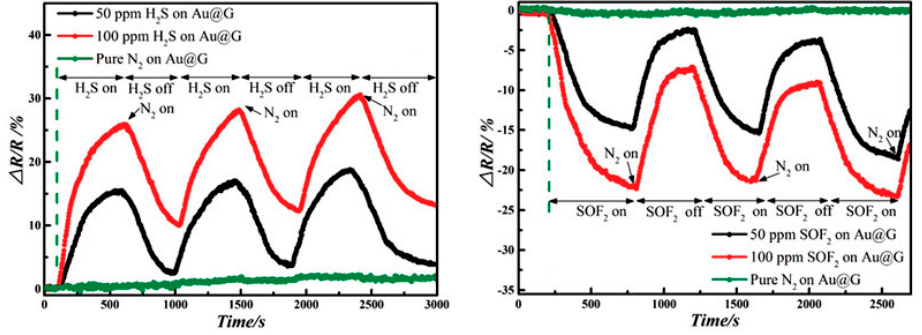
Figure 9. Repeated gas pulses effect of H 2 S and SOF 2 on Au-graphene. Reproduced with permission from [68]. Copyright 2015 Advanced Science.